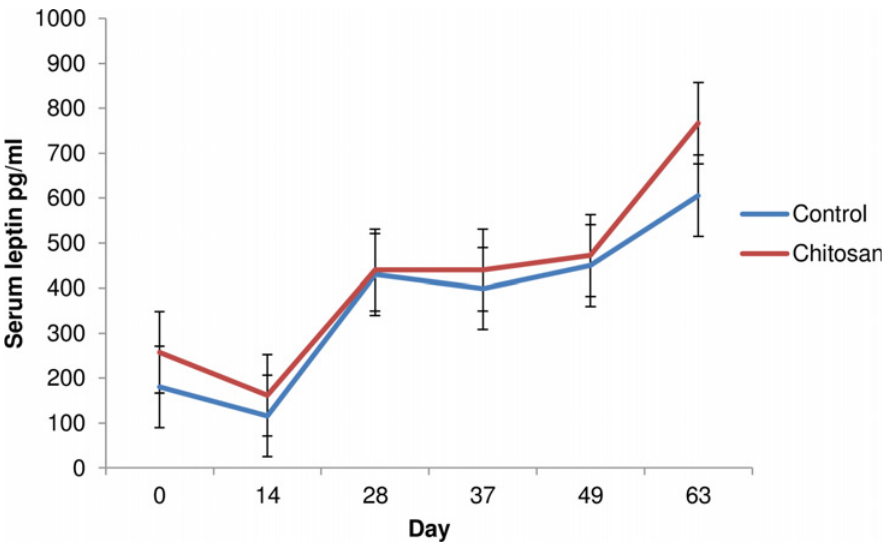
Fig 3. Effect of dietary supplementation on serum leptin levels over time at days 0, 14, 28, 37, 49 and 63. Treatment effect (P < 0.05). Time effect (P < 0.05). Values are means, with their standard errors represented by vertical